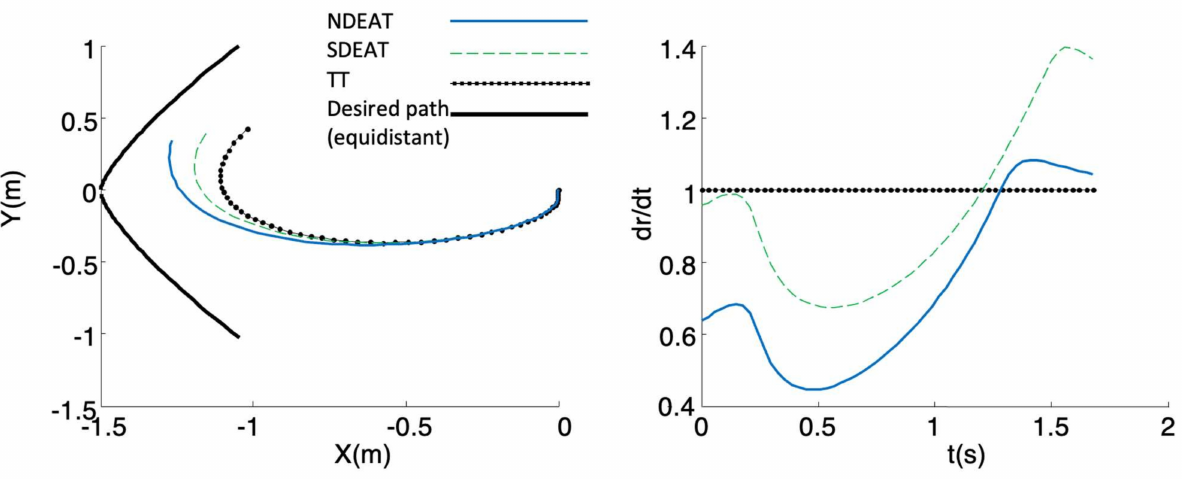
Figure 8. NDEAT, SDEAT and TT when the path is equidistant to the origin. Left : XY desired and real trajectories. Right : evolution of σ = dr / dt with respect to